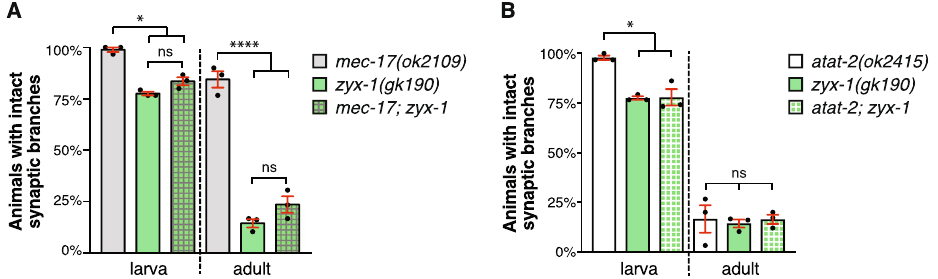
Figure 6. mec-17 and atat-2 function in the same genetic pathway as zyx-1 . ( a ) Quantification of animals with intact synaptic branches in mec-17(ok2109) and zyx-1(gk190) single and double mutants. Bars show mean ± SE; symbols show the mean of three-independent experiments, each with n ≥ 29 (total n ≥ 88). ( b ) Analysis atat- 2(ok2415) and zyx-1(gk190) single and double mutant animals. For each independent experiment, n ≥ 28 (total n ≥ 87). P values ns > 0.05, * < 0.05, **** < 0.0001 from one-way ANOVA with Tukey’s post-hoc